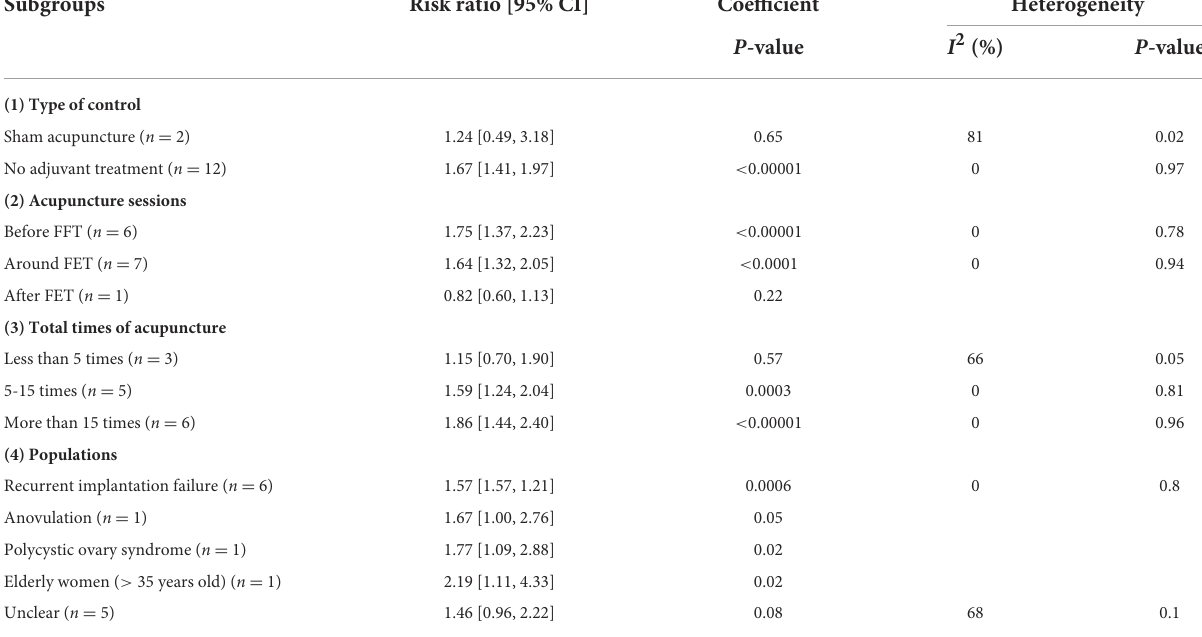
TABLE 2 Subgroup analyses on clinical pregnancy rate (random-effects model, n =